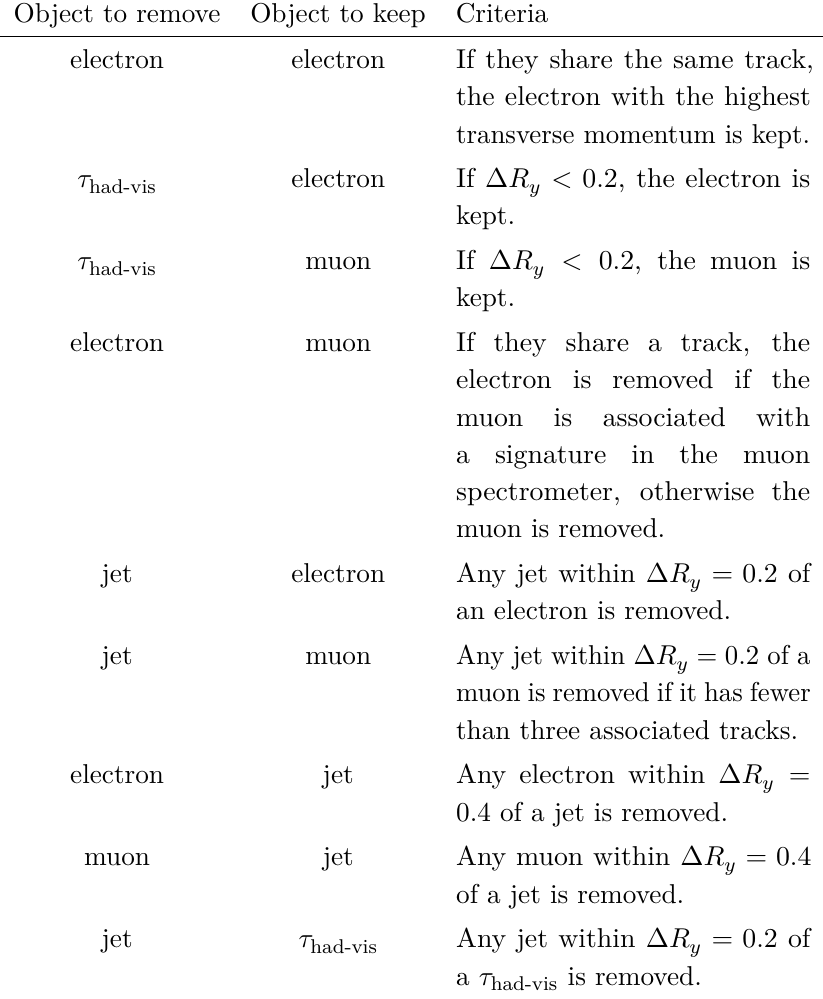
Table 3. Criteria applied to overlapping reconstructed objects. The criteria are listed in the order they are